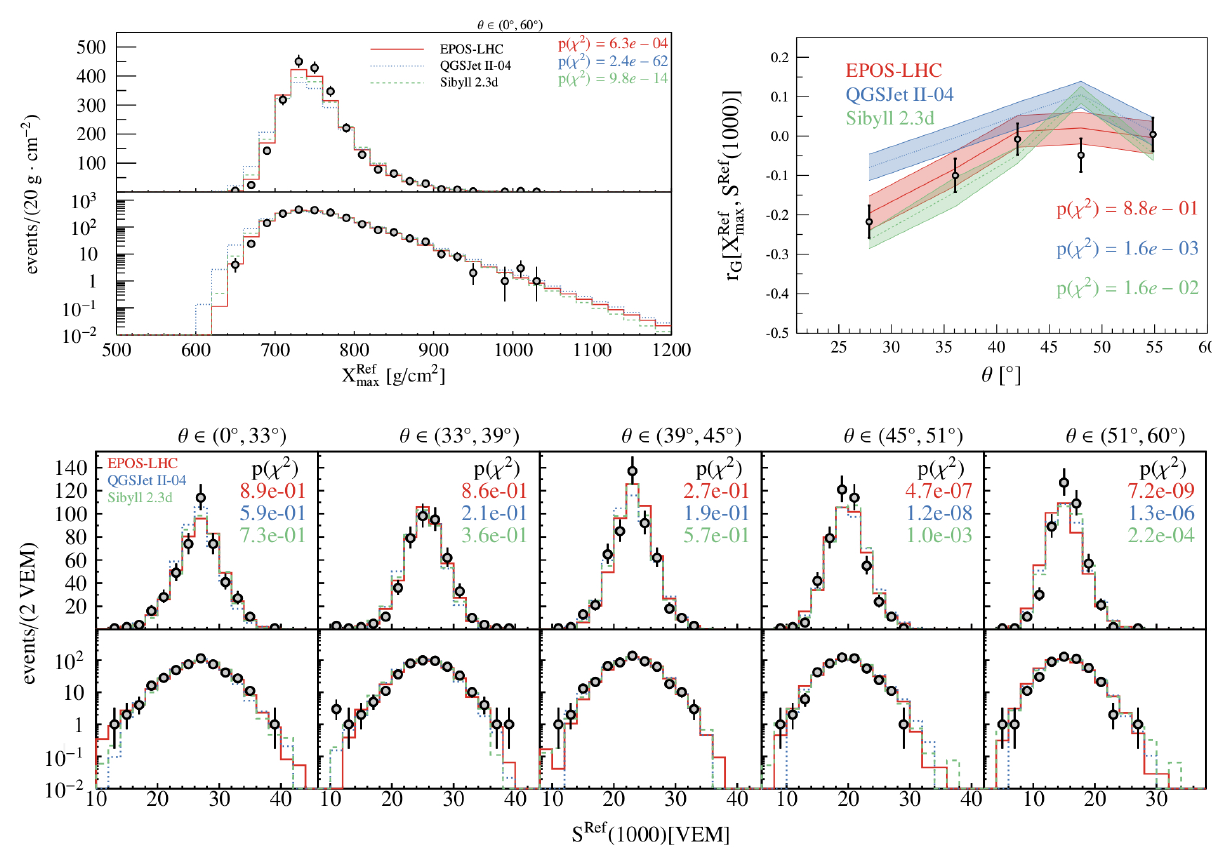
Figure 5: Composition fits with a freedom in R Had , see caption of Fig.